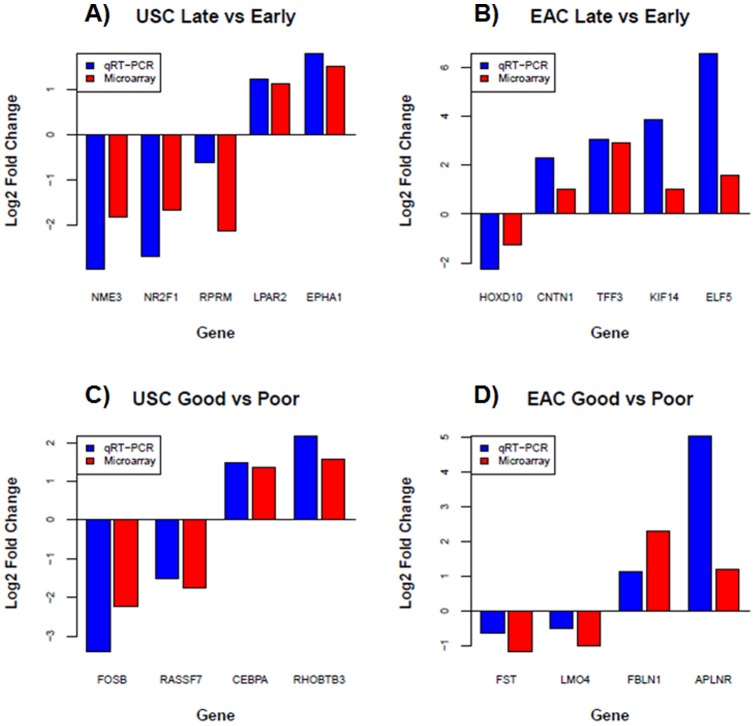
qRT-PCR validation of differentially expressed genes (P<0.01) with
at least two-fold expression change as identified by microarray.
A) stage-related DEGs (late versus early) in USC group.
B) stage-related DEGs in EAC group.
C) Outcome-related DEGs (good versus poor) in USC
group. D) Outcome-related DEGs in EAC group. Blue bar
is the fold change estimated by qRT-PCR, while red bar is the fold
change estimated by microarray. The fold change is shown in log2 scale
(i.e., >1 means at least 2-fold up, while <−1 means at least
2-fold down). The three genes with less than two-fold change in
expression level based on qRT-PCR are FST, LMO4 and
RPRM.